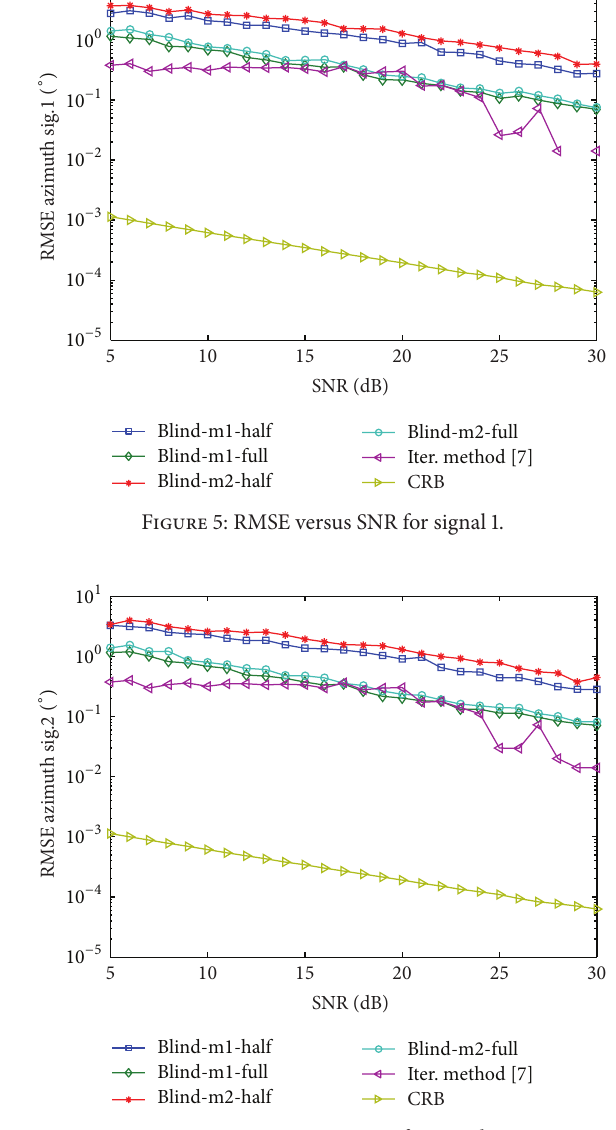
Figure 6: RMSE versus SNR for signal